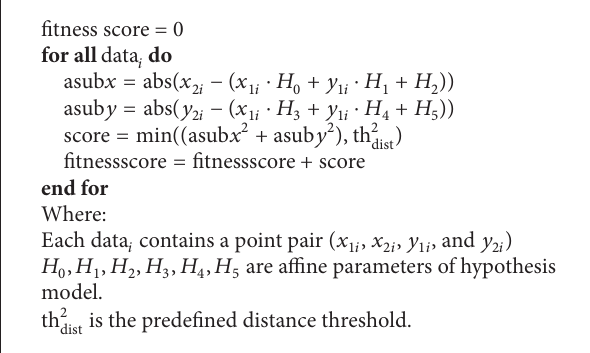
Algorithm 2: Fitness scoring in RANSAC